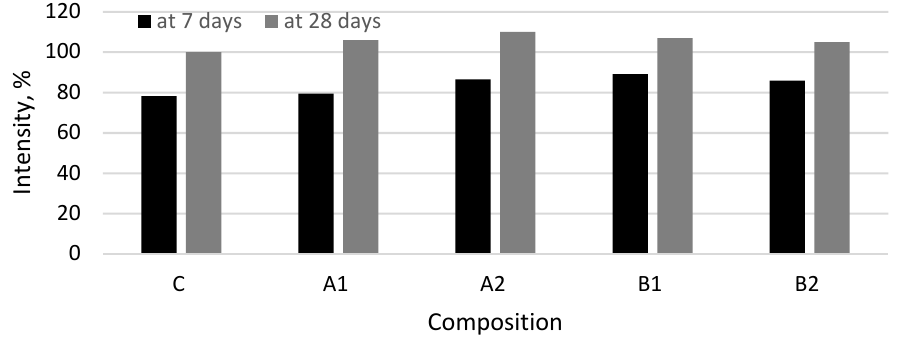
Figure 9. Semi-quantification of portlandite present is the samples assuming as reference for 100% content of the C paste at 28 days.